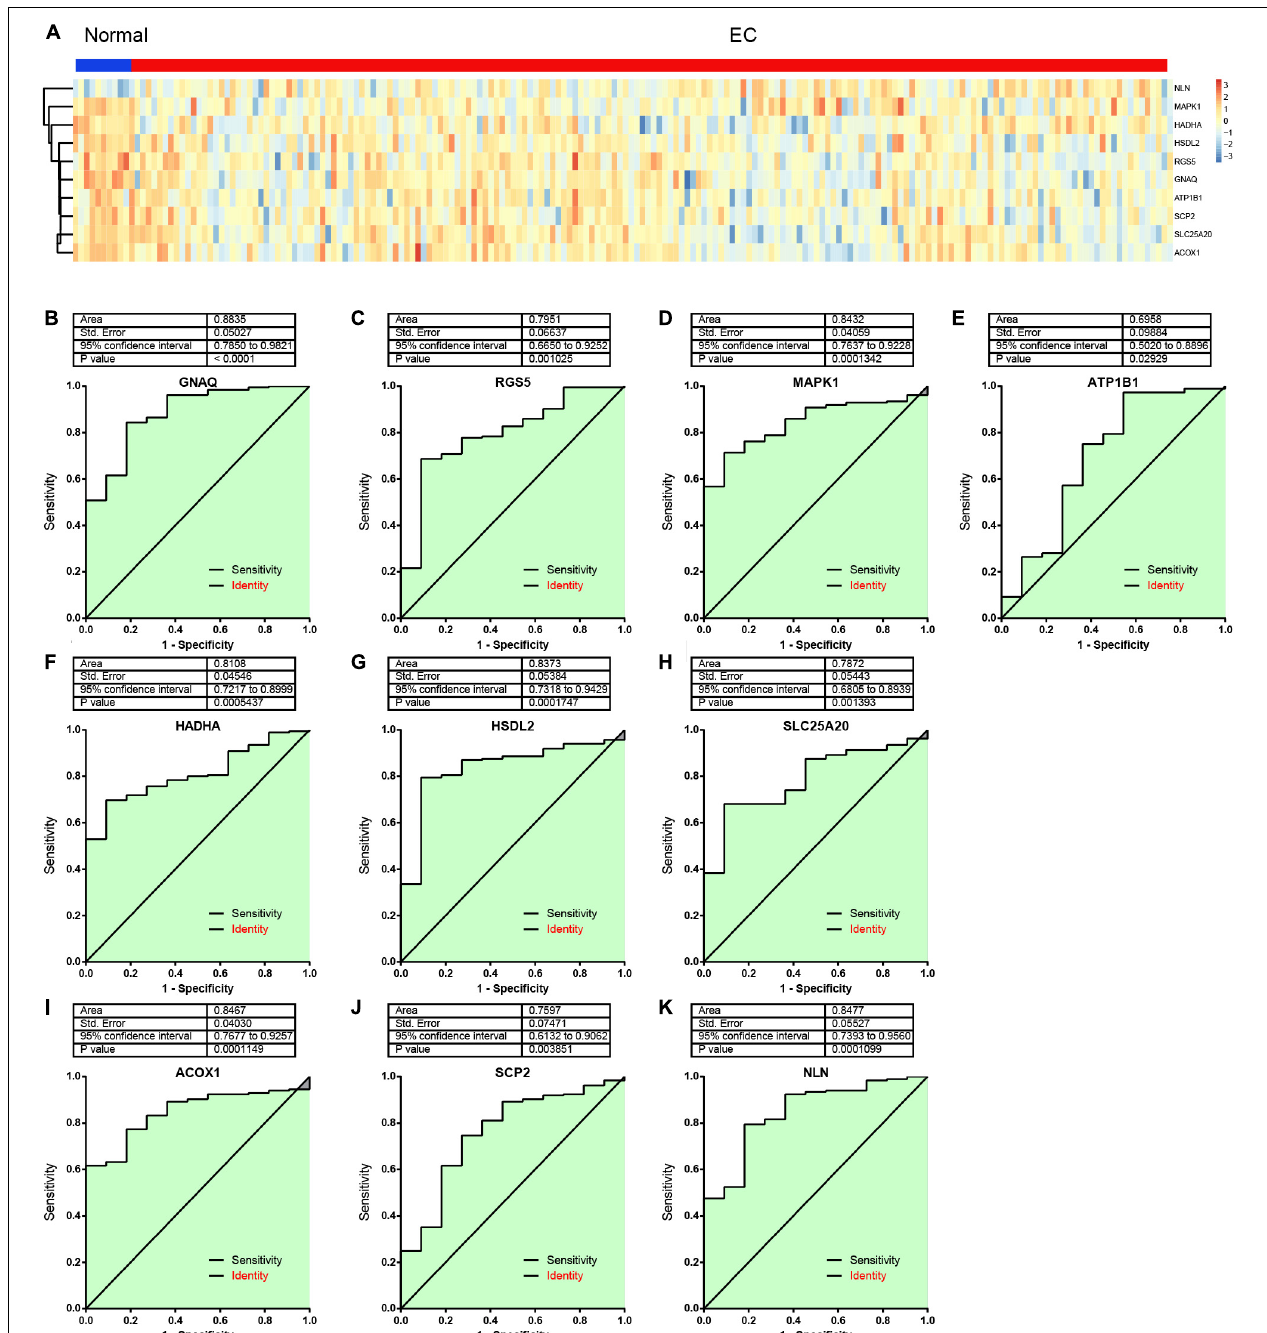
FIGURE 7 | The area under the curve (AUC) analysis of hub genes for distinguishing esophageal cancer (EC) samples from normal tissues. (A) The expression levels of hub genes in EC and normal samples were analyzed using The Cancer Genome Atlas (TCGA) database. (B–K) The area under the curve (AUC) analysis of GNAQ (B) , RGS5 (C) , MAPK1 (D) , ATP1B1 (E) , HADHA (F) , HSDL2 (G) , SLC25A20 (H) , ACOX1 (I) , SCP2 (J) , and NLN (K) for distinguishing EC samples from normal